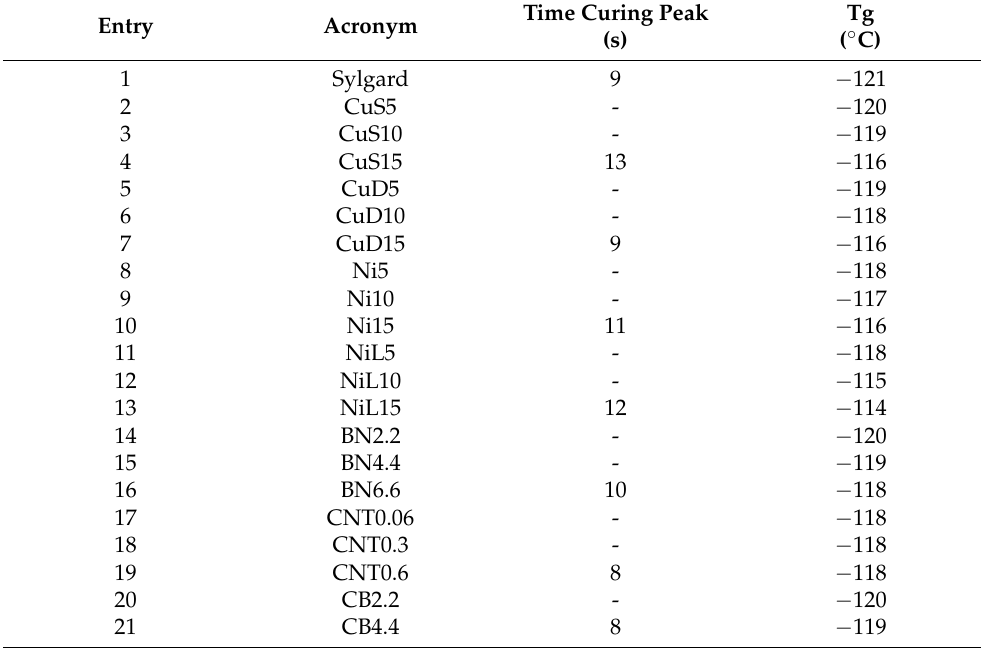
Table 2. Time-curing peak and TG values of silicone